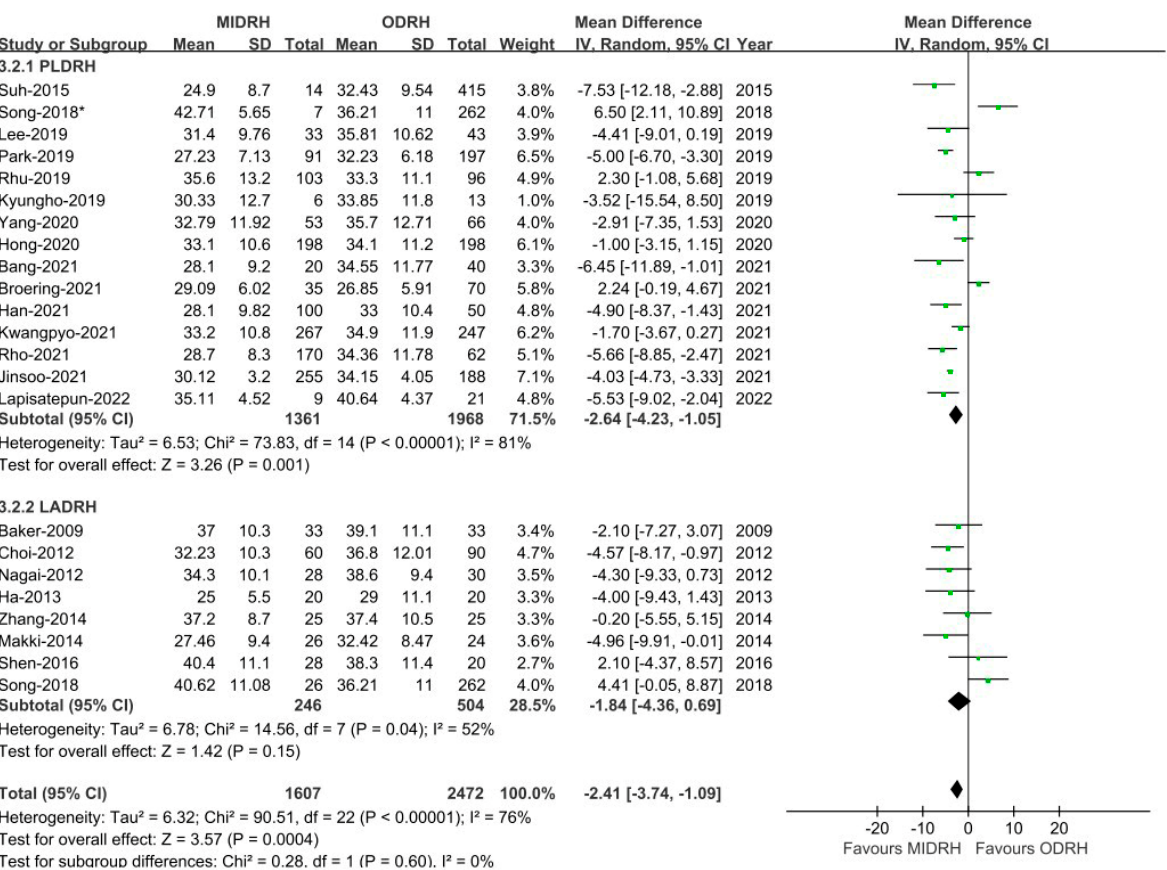
Figure 1. Flowchart of study identification and selection.